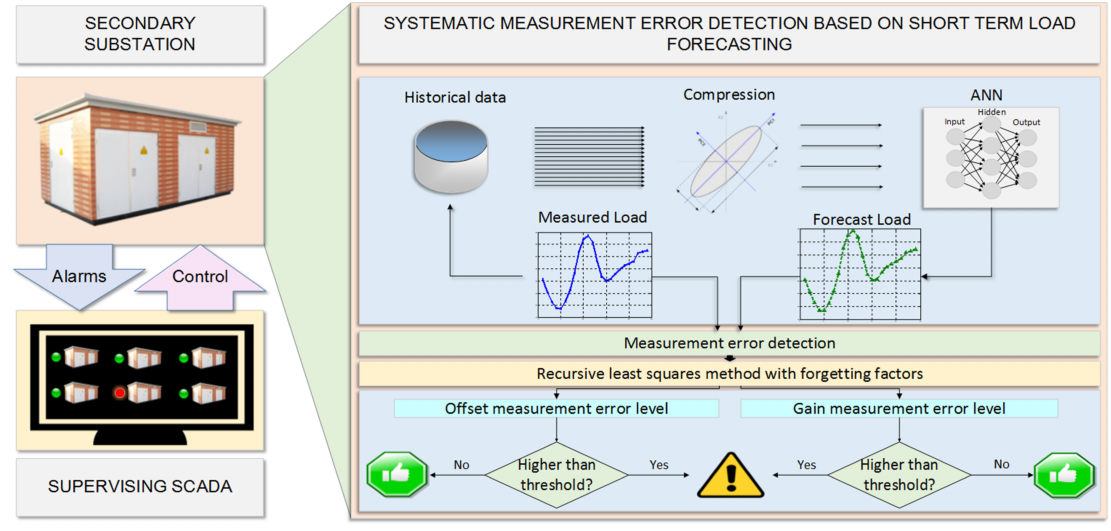
Figure 1. Overview of the general